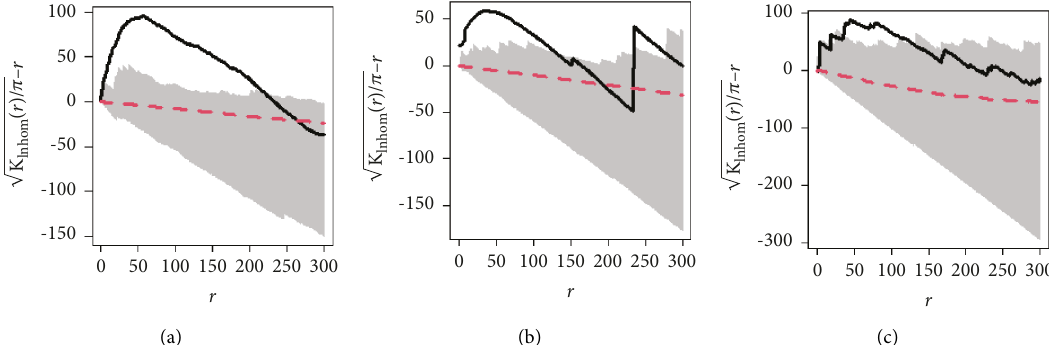
Figure 3: L-functions compared to an inhomogeneous Poisson null model, with estimated intensity through Gaussian kernel. (a), (b), and (c) as in the previous figure.